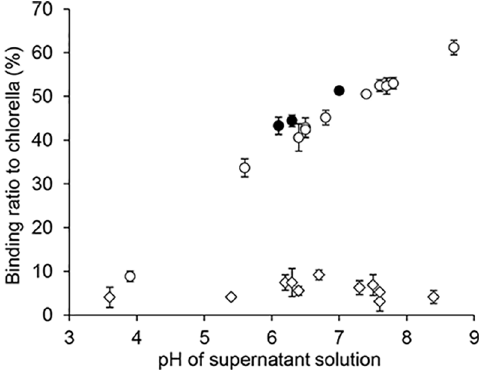
Fig 2. pH dependence of Chlorella adsorption. Binding ratios of 85 Sr (open circles) or 137 Cs (open diamonds) to Chlorella depended on the pH conditions. Binding ratios of 85 Sr (closed circles) after exposure to acidic conditions. Data are expressed as the mean ± SD of three